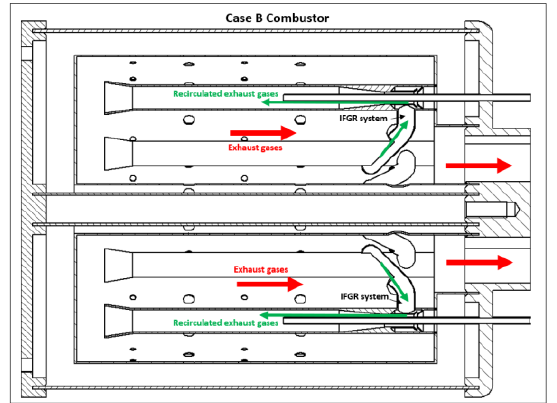
Fig. 5. External view of computational domain (external view is similar in all cases) and the mesh view in longitudinal cross sections for each com- bustor